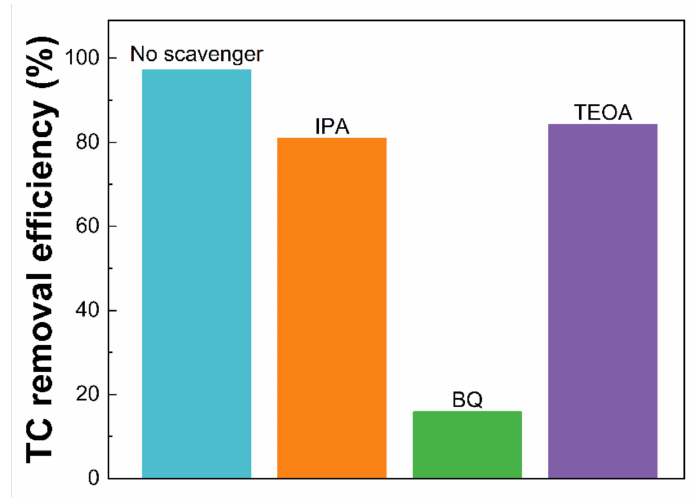
Figure 9. The influence of reactive species on TC removal efficiency